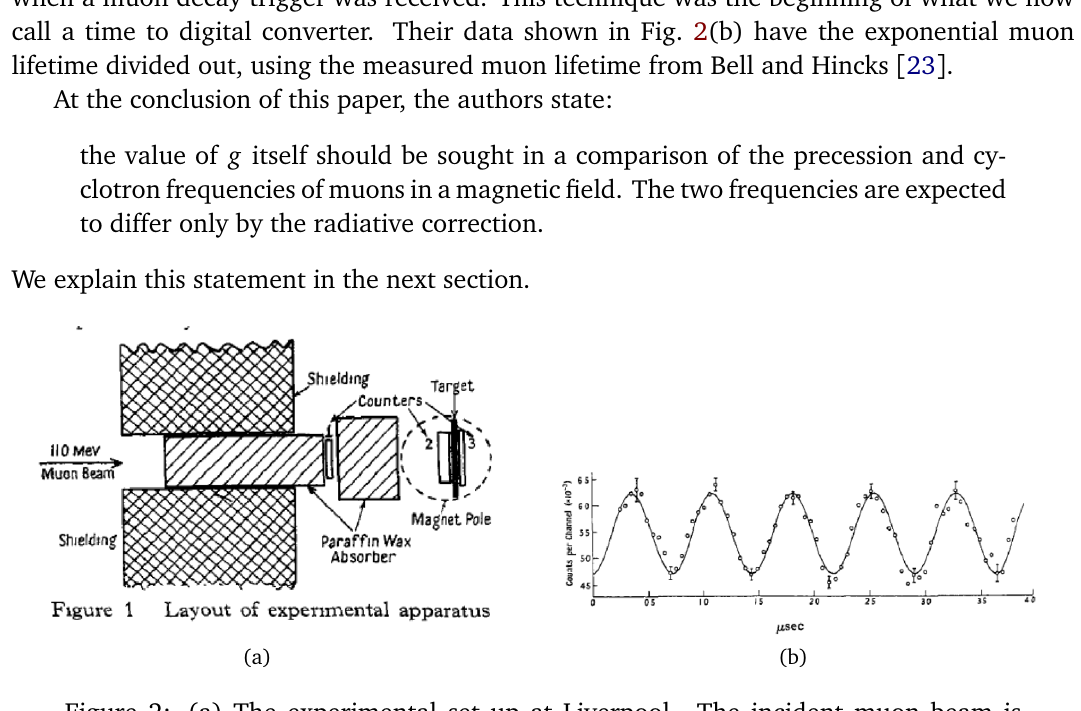
Figure 2: (a) The experimental set up at Liverpool. The incident muon beam is stopped in the target, 1 · 2 · ¯3 followed by a delayed 3 · ¯2, (From Ref. [ 22 ] . Copyright IOP Publishing. Reproduced with permission. All rights reserved.) (b) The muon time spectrum observed by Cassels et al. [ 22 ] as a function of time after the stopped muon, demonstrating the expected Larmor precession. The exponential muon life- time was divided out using the measured muon lifetime. (From Ref. [ 22 ] Copyright IOP Publishing. Reproduced with permission. All rights